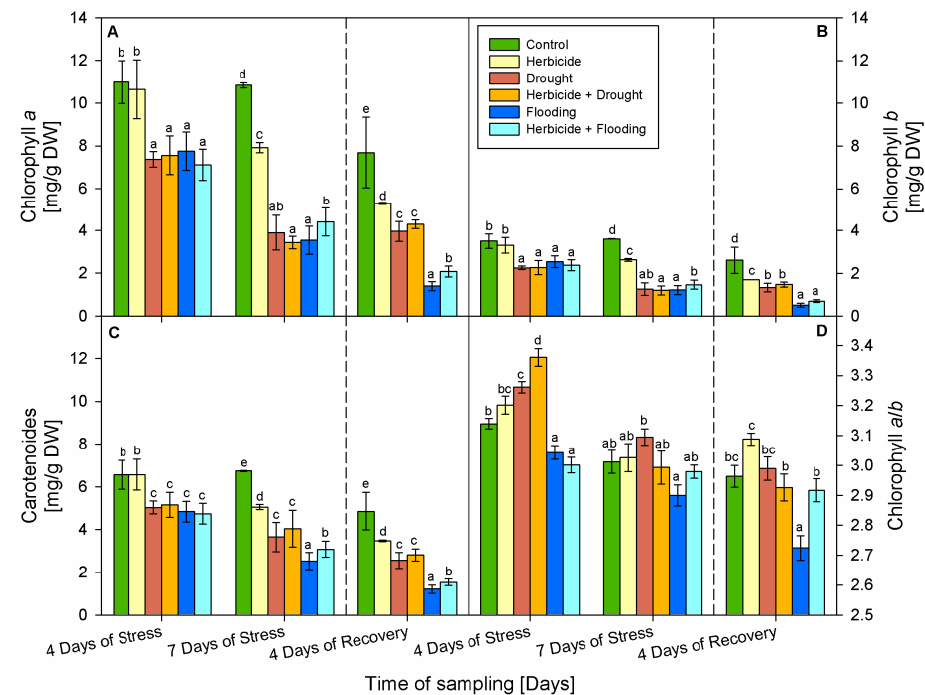
Figure 2. Chlorophyll a ( A ), chlorophyll b ( B ), carotenoids ( C ) content and chlorophyll a / b ratio ( D ) in wheat plants treated with herbicide and subjected to drought or flooding stress. Data are mean values ± standard errors. Different small letters denote significant differences between mean values at p < 0.05.